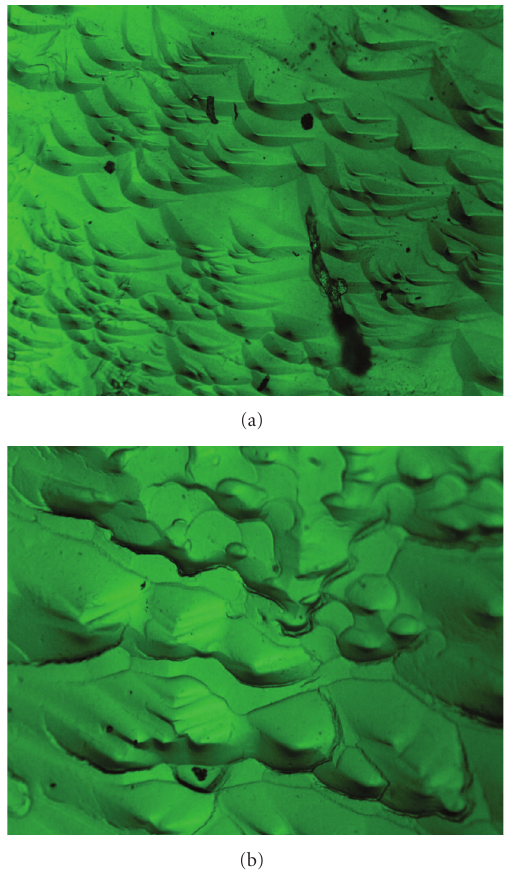
Figure 8: (a) Pure TGS (b) 1 mole % LiSO 4 -doped TGS